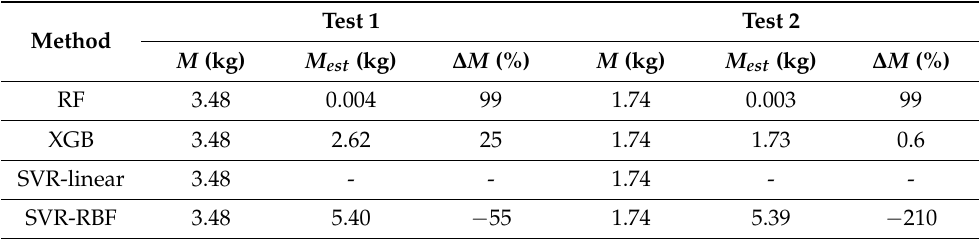
Table 10. Predicted spill mass of ML models using the measured BTCs of Tests 1 and